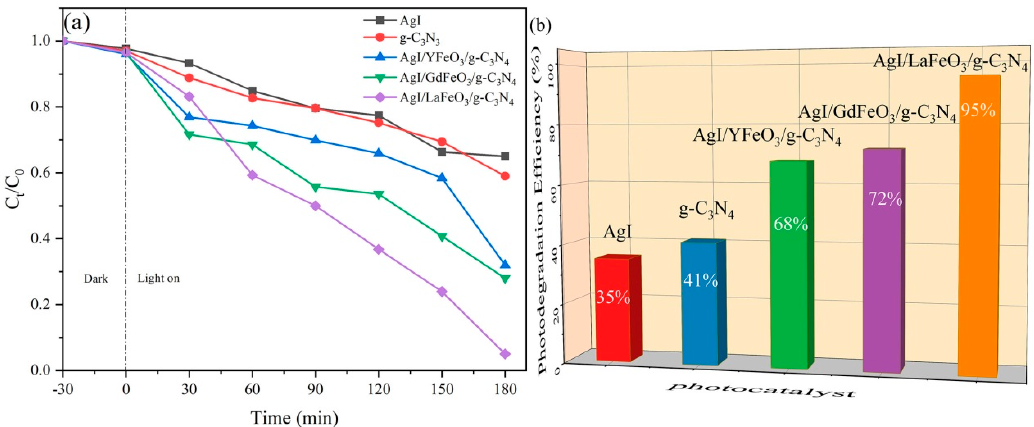
Figure 7. ( a ) Concentration of NOF changing with time for 180 min under xenon lamp irradiation and ( b ) photodegradation rate of NOF over AgI, g-C 3 N 4 and AgI / MFeO 3 .g-C 3 N 4 (M = Y, Gd,